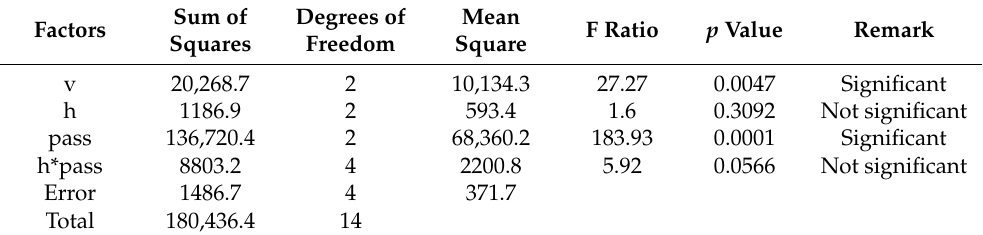
Table 7. ANOVA table for the radial residual stress on the surfaces.